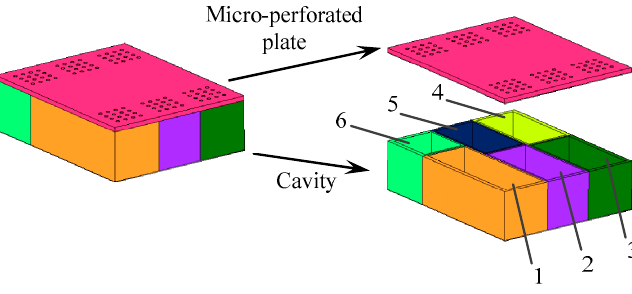
Figure 14. Schematic view of the planar BAU.